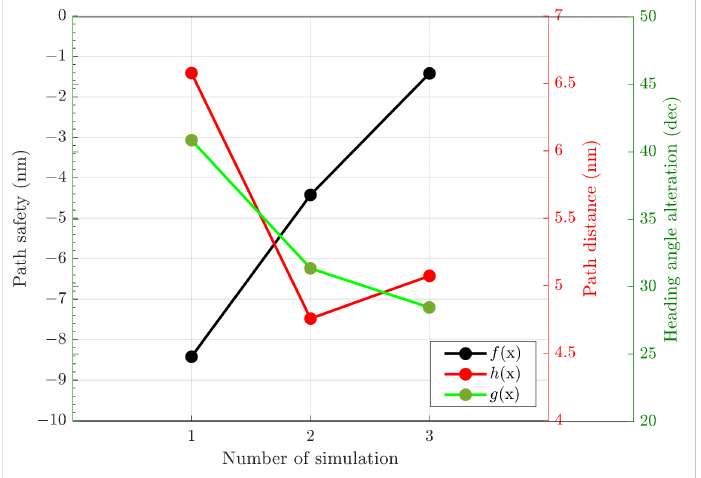
Figure 10. Path planning results with different weight coefficients under a head-on situation.